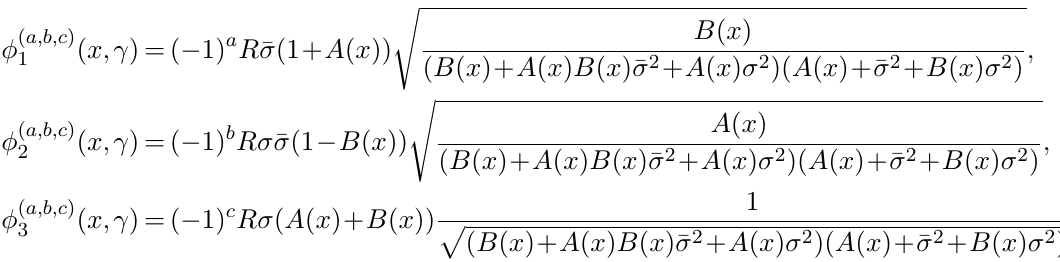
Figure 7 . Orbits for several members of the family K ( q;a;b;c ) and wall tension densities (right) graphically represented in Cartesian